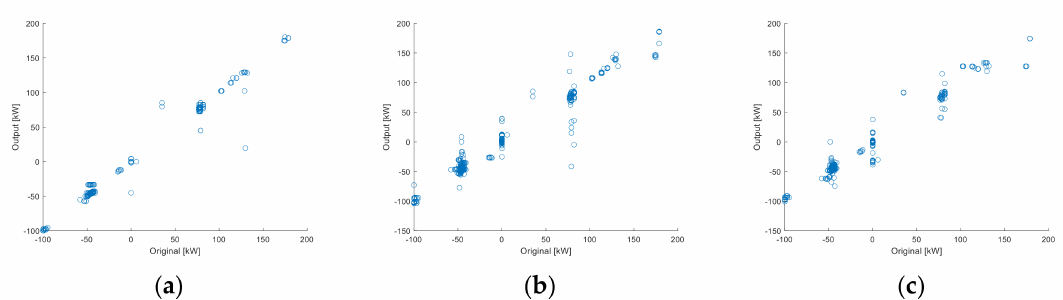
Figure 9. Scatter plot of all simulation results: ( a ) comparison of original data and proposed output with decision tree, ( b ) comparison of original data and proposed output with NARX, ( c ) comparison of original data and proposed output with